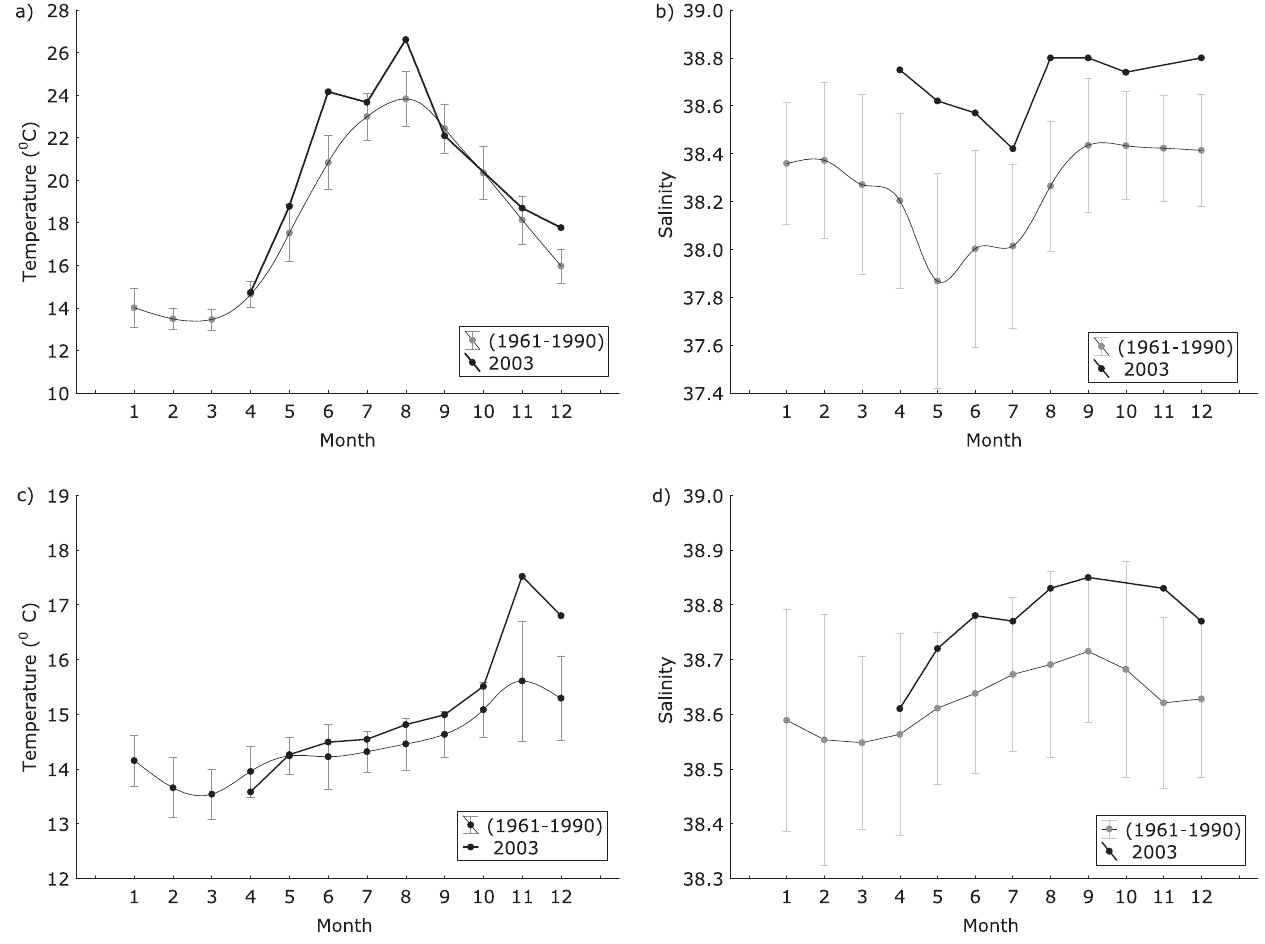
Fig. 6. Monthly mean surface temperature (a) and salinity (b) , and bottom temperature (c) and salinity (d) at the station CJ009 for the period 1961–1990 and for